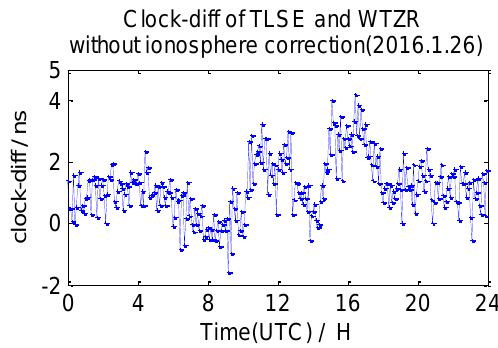
Figure 11. Clock difference between TLSE and WTZR (without ionosphere correction).